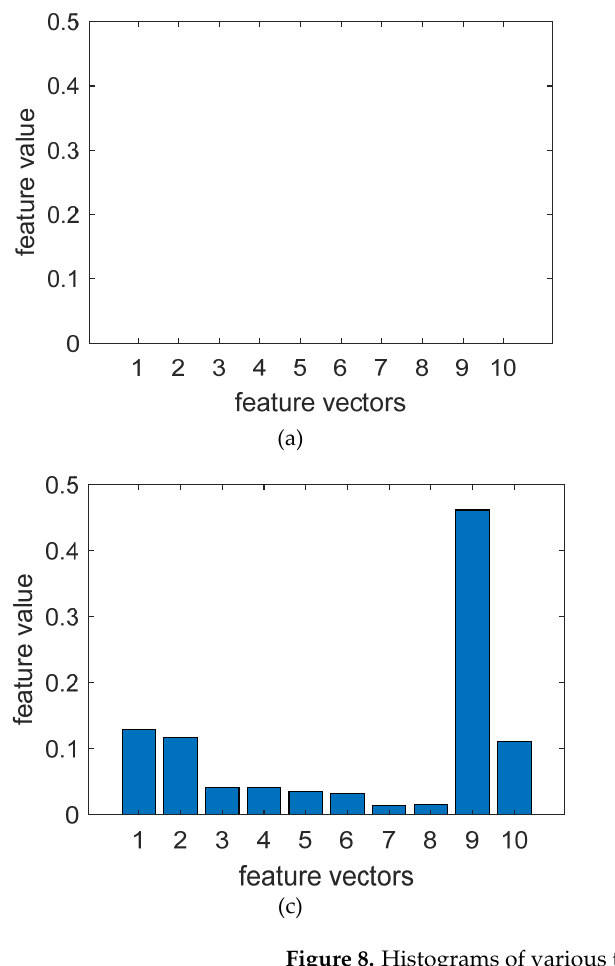
Figure 8. LBP riu 2 Histograms of various types of forest fire images : ( a ) without fire; ( b ) with fire-like interference.